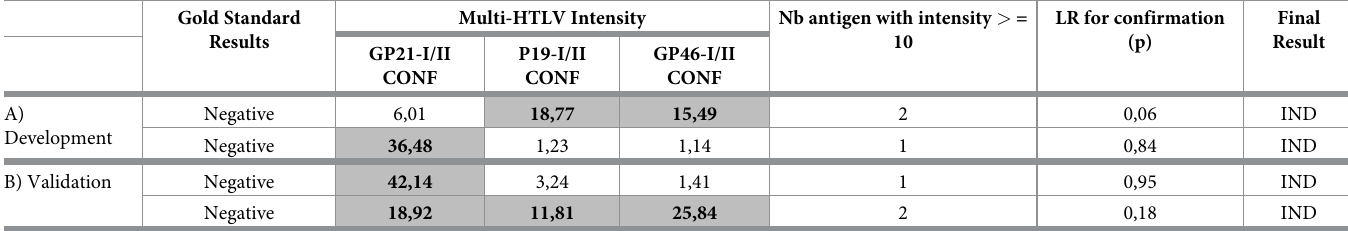
Table 4. Multi-HTLV intensities for indeterminate samples.